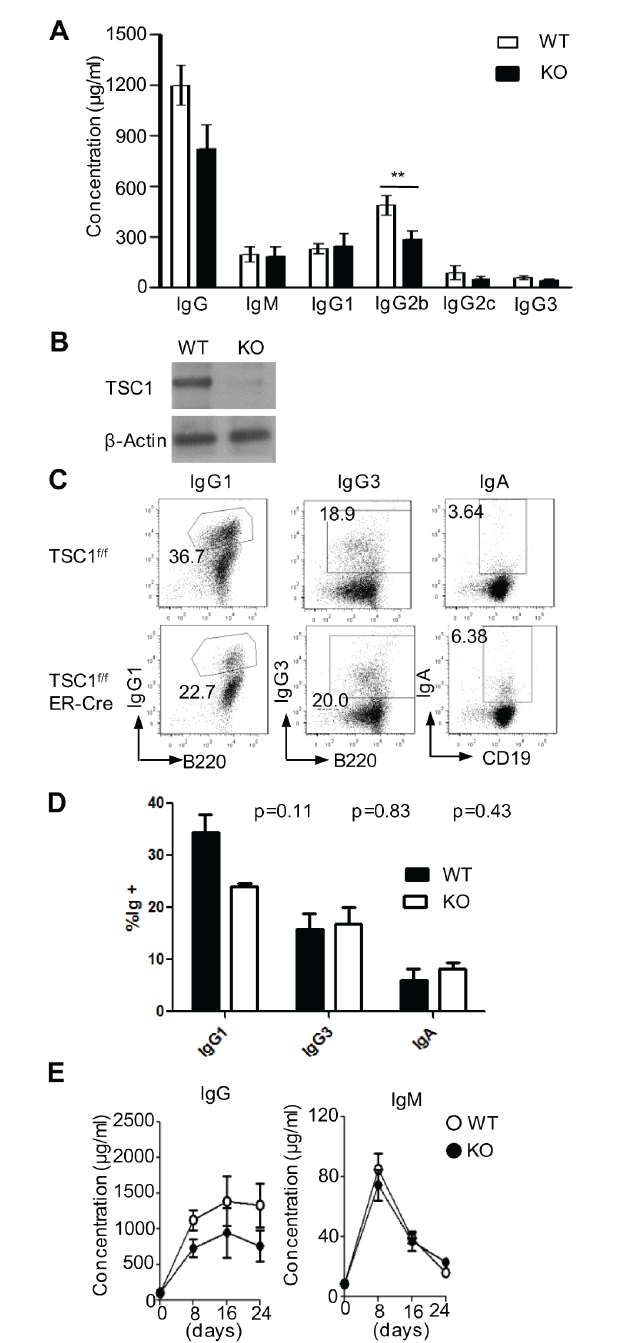
Fig 6. Effects of TSC1 deficiency on Ig CSR and serum antibody responses. (A) Serum Ig levels in unimmunized WT and TSC1KO mice (n = 9). (B) TSC1 protein levels in sorted B220 + B cells from Tsc1 f/f ERcre - and Tsc1 f/f ERcre + mice after tamoxifen injections. (C, D) CSR is not significantly reduced in TSC1-deficient B cells. B cells from Tsc1 f/f ERcre - and Tsc1 f/f ERcre + mice after multiple tamoxifen injections were purified and induced to CSR to the indicated isotype for 4 days and analyzed by flow cytometry. (C) Representative dot plots from cells induced to switch to IgG1 (n = 3), IgG3 (n = 2), and IgA (n = 3). (D) Quantification of data from (C). Shown are means ± SD. IgG1 and IgA samples were subjected to 2-tailed paired Student ’ s t test, and IgG3 was subjected to 2-tailed unpaired Student ’ s t test. (E) Serum NIP 25 -specific IgM and IgG in the same mice immunized with NP 11 -CGG in alum, as described in Fig 5D – 5G (n = 6). * p < 0.05; ** p <